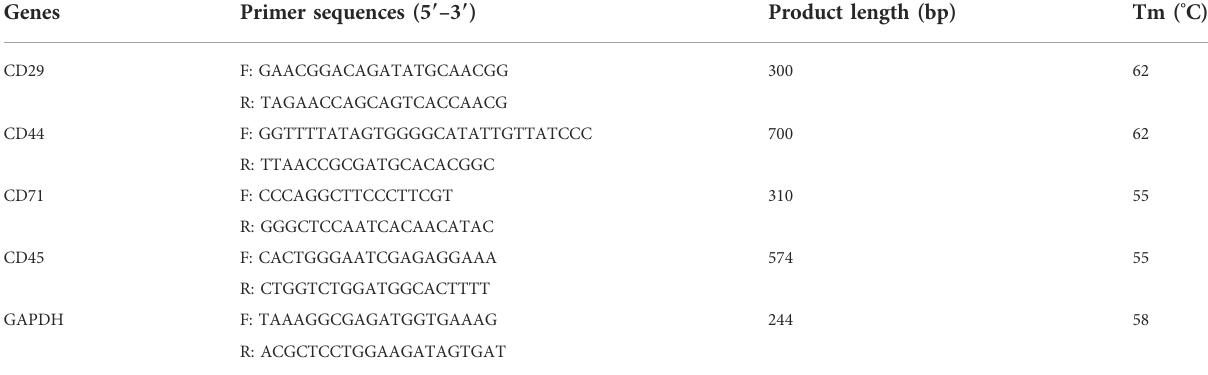
TABLE 1 The primers for BMSCs identi fi cation.